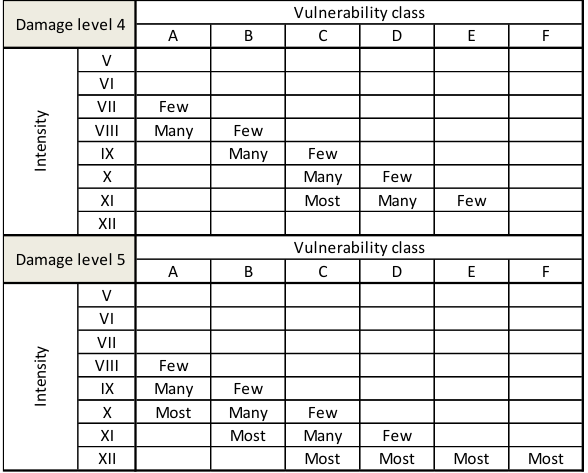
Table 4. Damage matrices for levels 4 and 5.